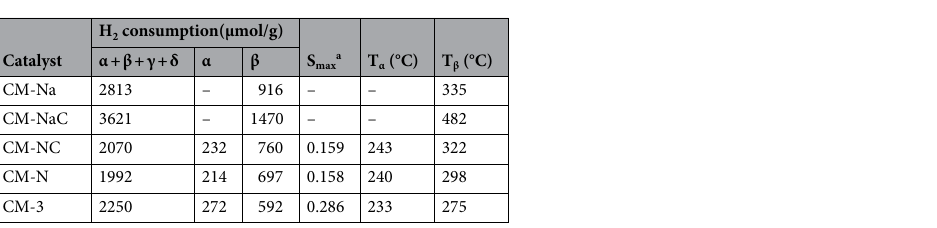
Table 2. Reducing property of cerium manganese catalysts. a The maximum slope of the α reduction peak.